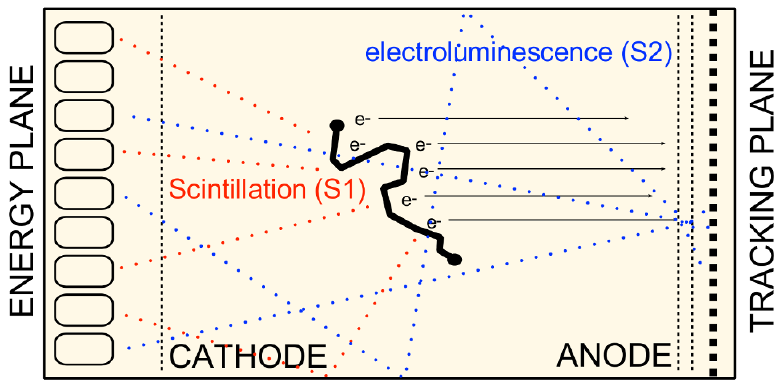
Figure 1 . Schematic of the EL-based TPC developed by the NEXT collaboration for double-beta decay searches in 136 Xe